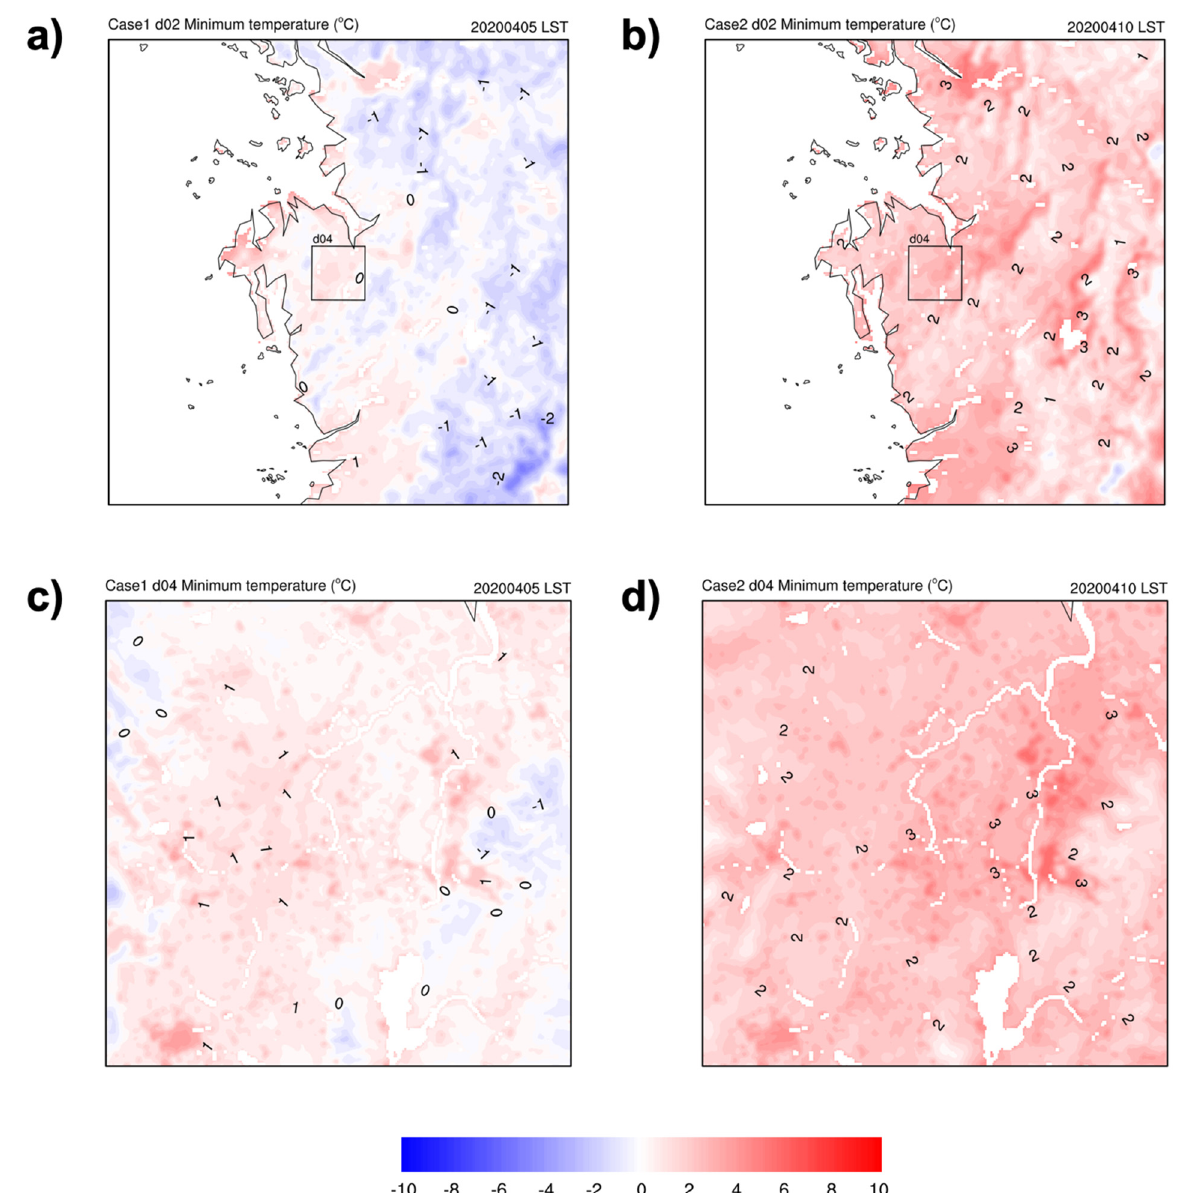
Figure 8. WRF-simulated result of daily minimum air temperature (°C) for domain 2 ( a , b ) and WRF–LES-simulated results for domain 4 ( c , d ).